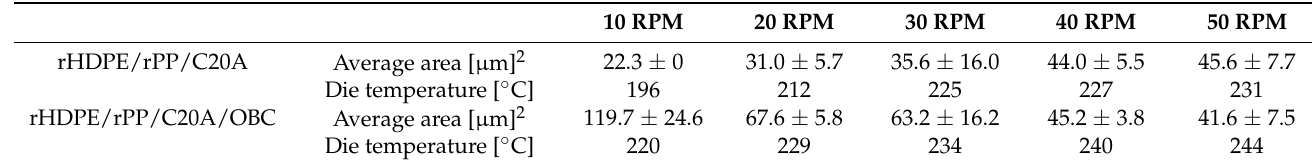
Figure 8. SEM images of the 92% rHDPE/rPP, 3% C20A, and 5% OBC blend: ( a ) 10 RPM, ( b ) 20 RPM, ( c ) 30 RPM, ( d ) 40 RPM, and ( e ) 50 RPM. Table 2. Average area of Cloisite 20A dispersed in rHDPE/rPP matrix with/without the OBC com- patibilizer.